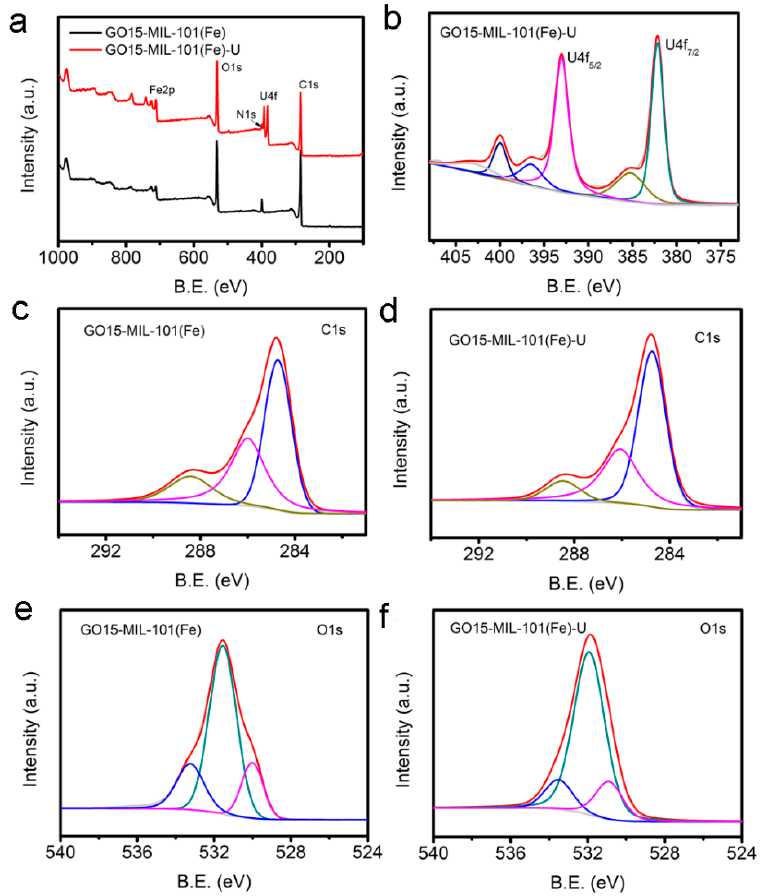
Figure 3. ( a ) The survey spectra obtained from X-ray photoelectron spectroscopy (XPS) of GO15-MIL- 101(Fe) before and after the adsorption of U(VI), high-resolution spectra of U4f for ( b ) GO15-MIL- 101(Fe)-U, C1s for ( c ) GO15-MIL-101(Fe) and ( d ) GO15-MIL-101(Fe)-U, O1s for ( e )